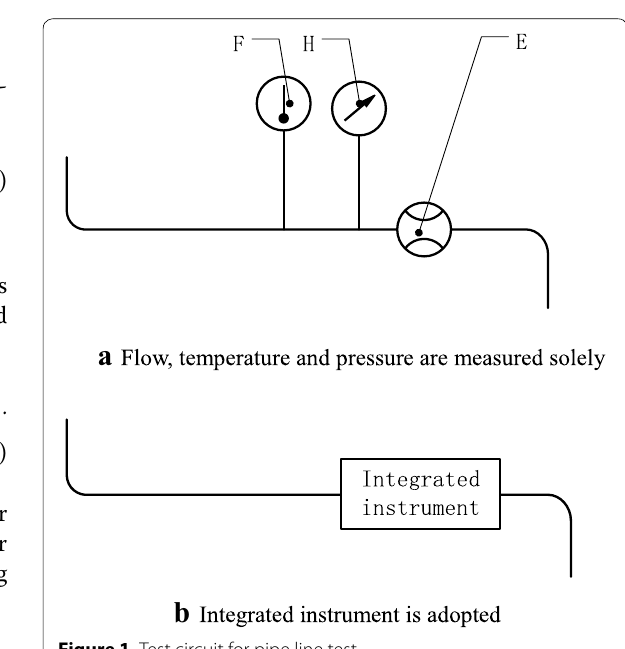
Figure 1 Test circuit for pipe line